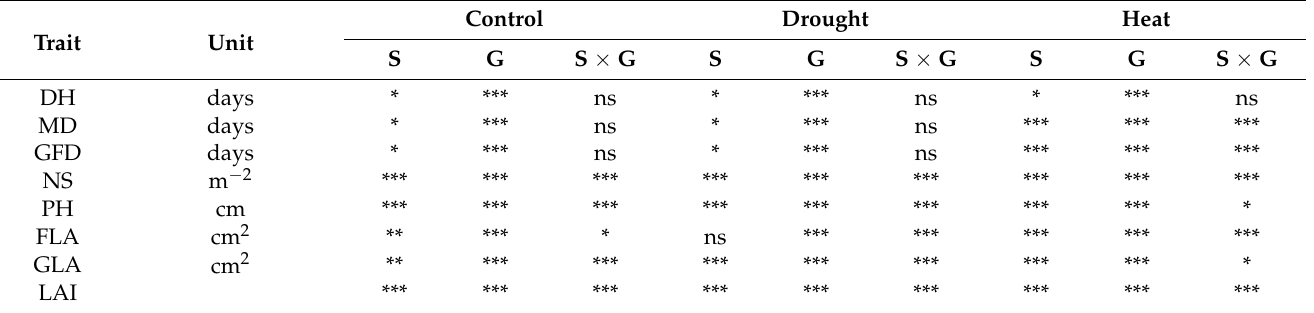
Table 2. Analysis of the variance of the seasons (S), genotypes (G), and their interactions (S × G) for the 20 studied traits of 20 wheat genotypes measured in three